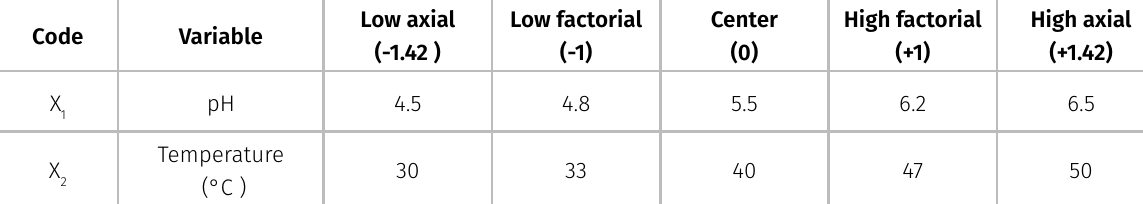
Table I. Experimental ranges and levels of temperature and pH.